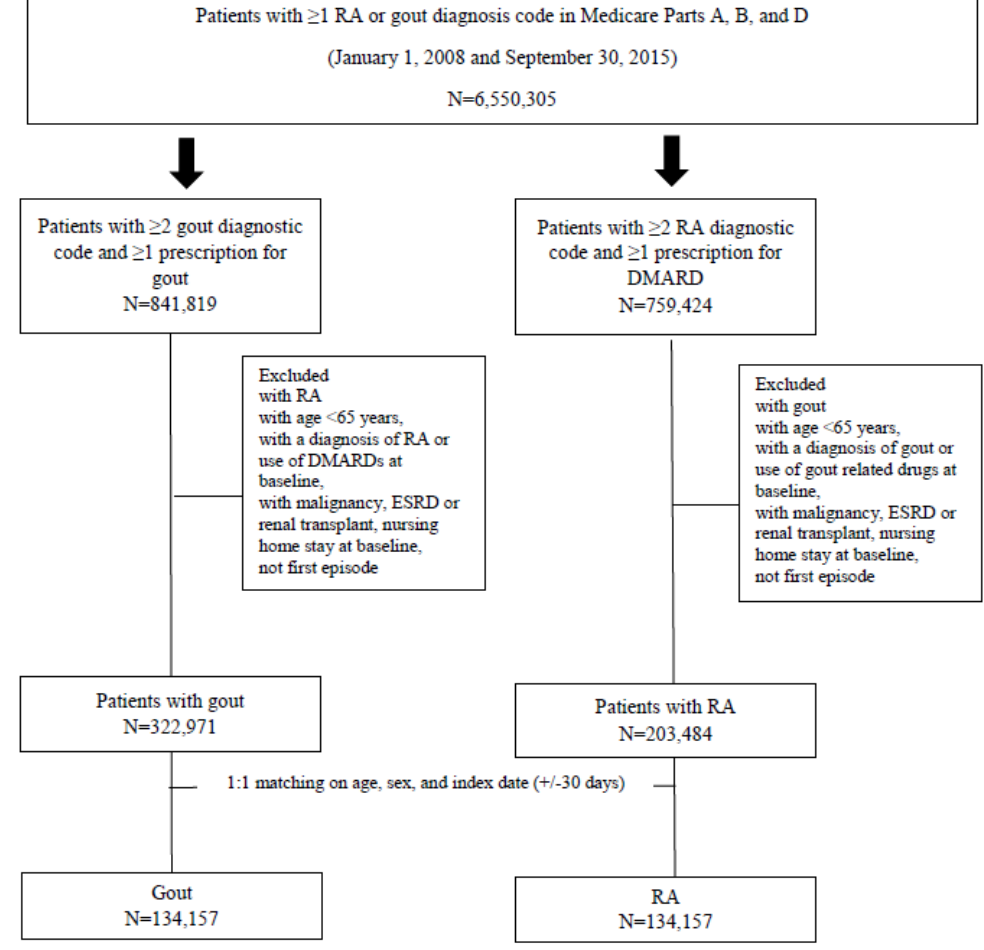
Figure 1. Flow diagram of cohort selection. RA: rheumatoid arthritis, DMARDs: disease modifying anti-rheumatic drugs, ESRD: end stage renal disease.